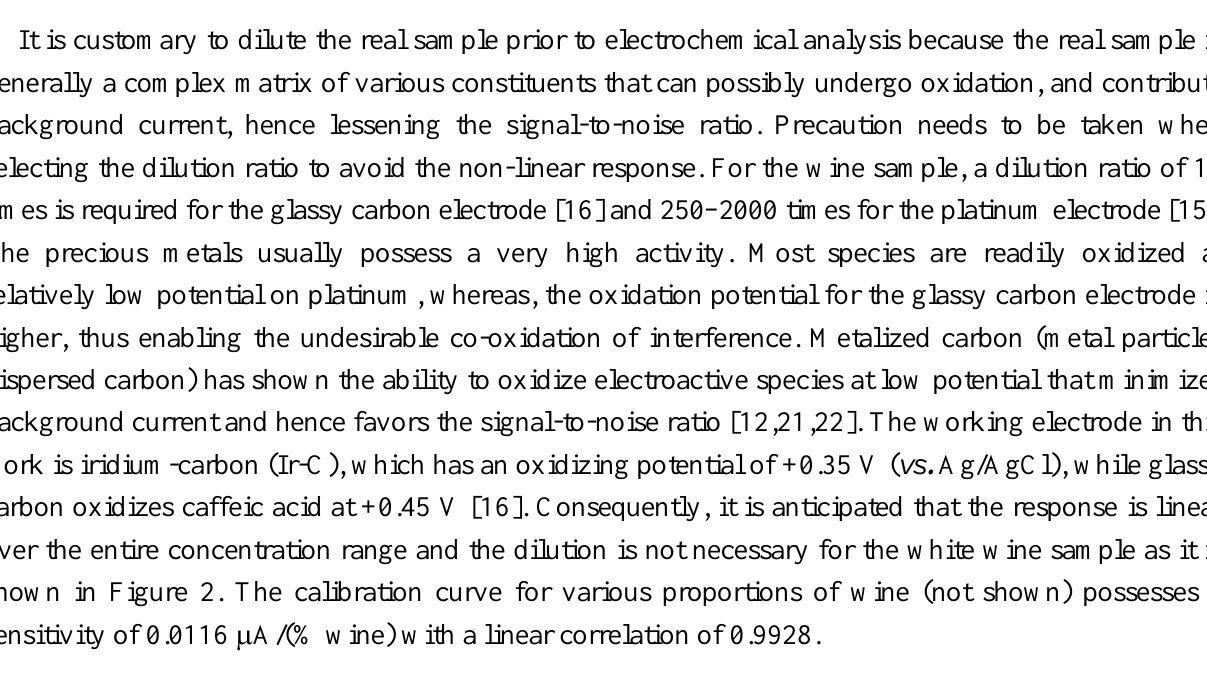
Figure 2. Voltammograms of wine sample at different dilution